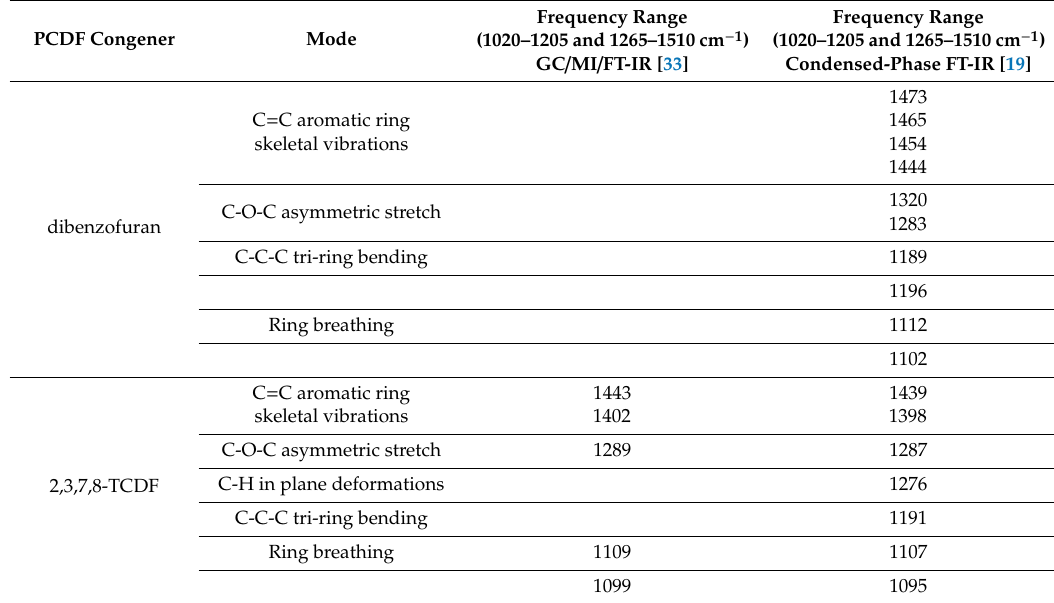
Table 2. Principal FT-IR bands of PCDFs. Reprinted with permission from [19], copyright